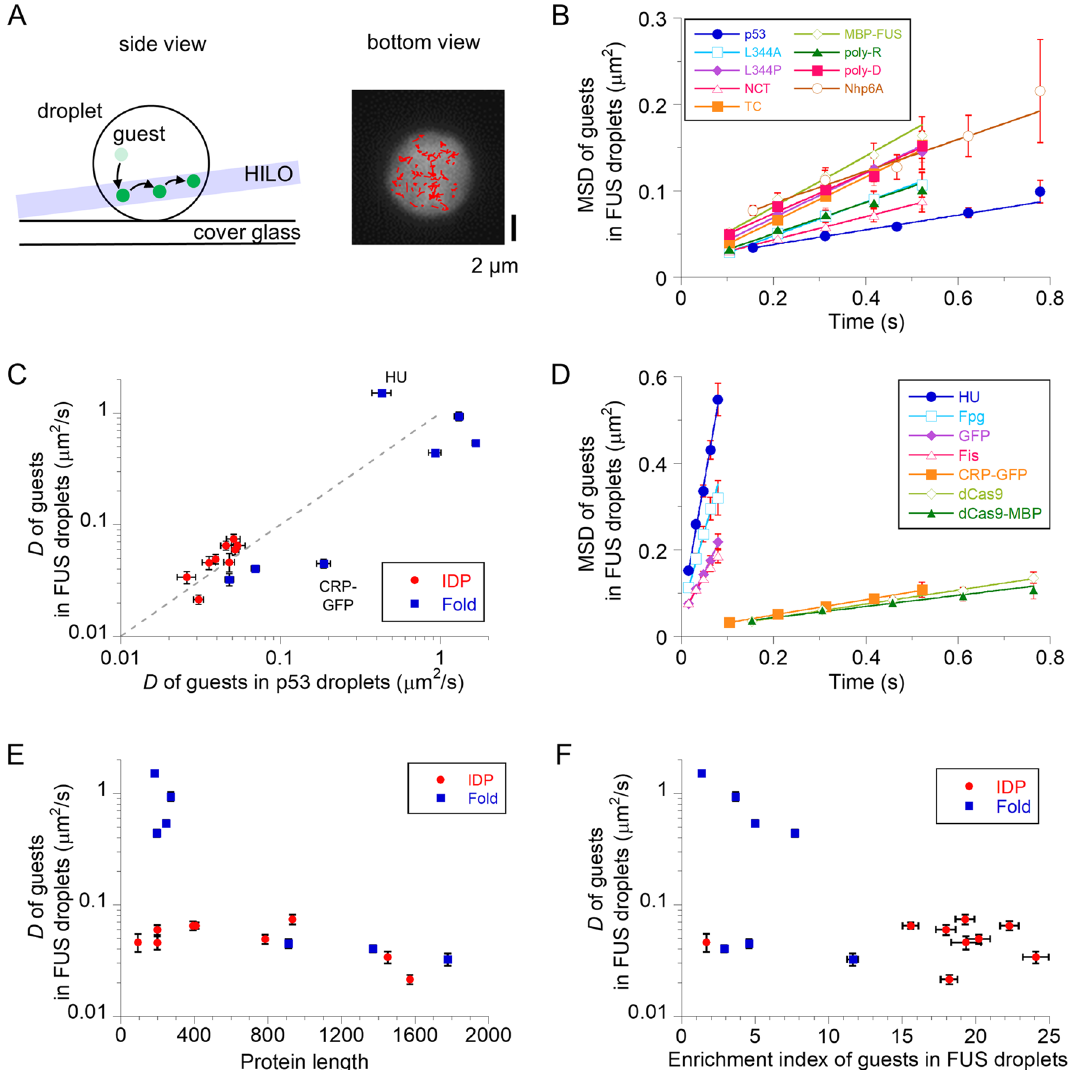
Figure 3. Translational diffusion of guests in FUS droplets depend on the structural type. ( A ) Schematic diagram of single-molecule tracking of fluorescent guests in a droplet (side view) and typical trajectories of guest FUS-MBP molecules in a non-labeled FUS droplet (bottom view). In the left panel, highly inclined and laminated optical sheet (HILO) illumination minimizes background fluorescence, enabling single-molecule detection of guests (green) in droplets. In the right panel, the typical trajectories of single molecules (red) are overlaid in time-averaged fluorescent images (white droplet). ( B ) Mean square displacement (MSD) plots of the labeled intrinsically disordered proteins (IDPs) and artificial polymers in non-labeled FUS droplets. ( C ) Two dimensional plot of diffusion coefficient ( D ) of the guest proteins into p53 versus FUS droplets. The data in p53 droplets were plotted from the Ref. 13 . The grey dashed line ( D FUS = D p53 ) is displayed as a guide for eye. ( D ) MSD plots of labeled folded proteins, CRP-GFP, and GFP in non-labeled FUS droplets. ( E ) Protein length dependence of the average D of guest proteins in FUS droplets. ( F ) Enrichment index (EI) dependence of the average D of guest proteins in FUS droplets. In all panels except for ( A ), errors of EI and D denote the standard and fitting errors,